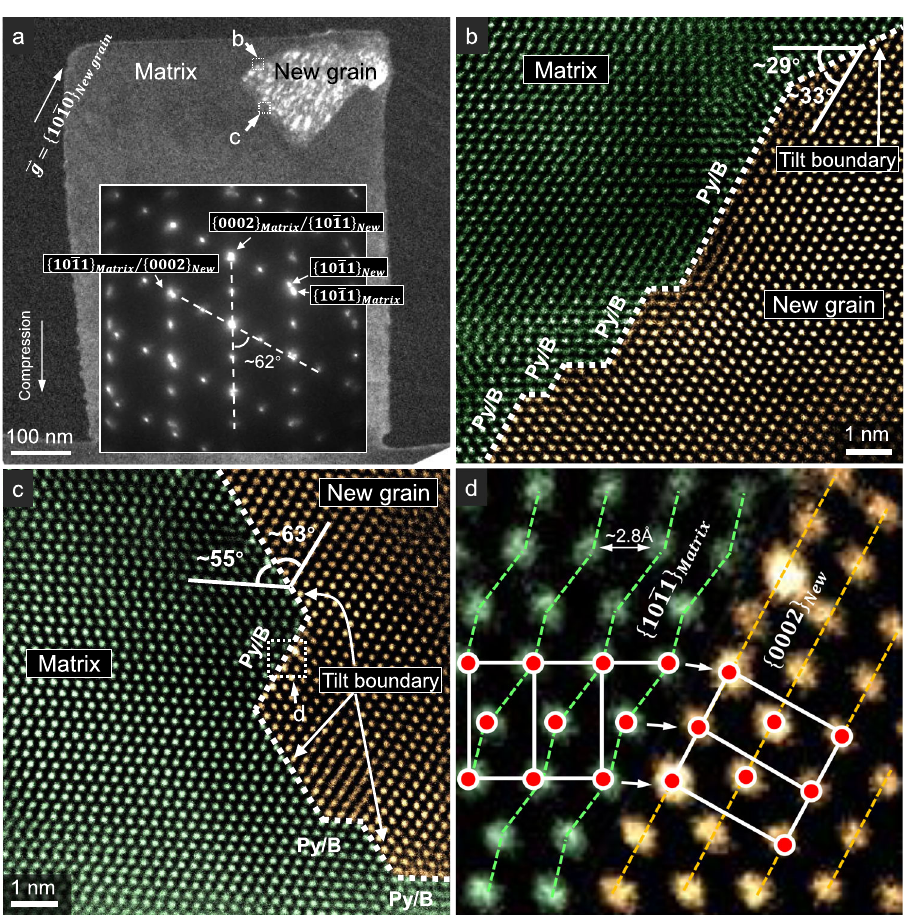
Fig. 4 Atomic structure of the grain boundaries of a new grain formed during c -axis compression. a TEM dark- fi eld image showing the morphology of this new grain. The inset selected area diffraction patterns indicate the orientation relationship of f 10 (cid:1) 11 g b , c Py/B interfaces and basal plane tilt boundaries, acquired from the places marked by the white dashed frames labeled by “ b ” and “ c ” in a , respectively. d Fine structure of the Py/B interface, acquired from the place marked by the white dashed frame labeled by “ d ” in c . The green and orange dashed lines are the traces of corrugated f 10 (cid:1) 11 g and fl at f 0002 g planes, respectively. The HCP unit cells of the matrix and the new grain are highlighted by the white lines and red circles. The zone axis is (cid:2)h 2 (cid:1) 1 (cid:1) 10 i